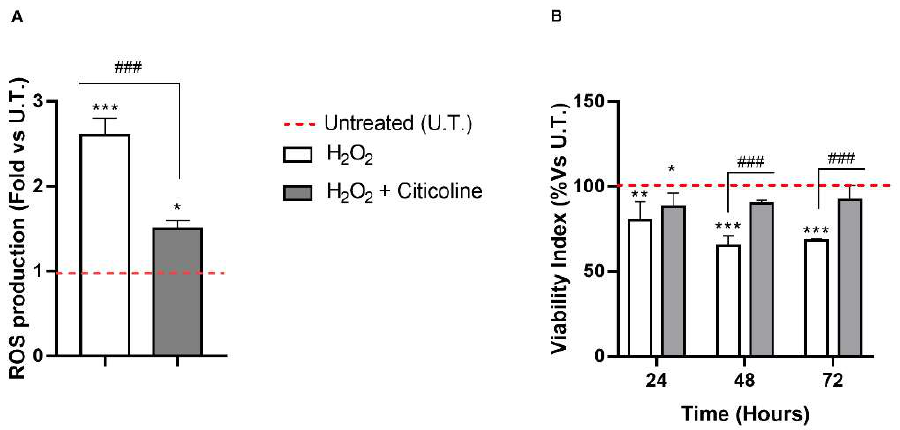
Figure 1. Citicoline counteracts H 2 O 2 -mediated cytotoxicity in HTMC. ( A ) DCF Assay was performed on untreated and treated HTMCs, and fluorescence was recorded at 2 h of experimental procedures. Data are expressed as a fold of ROS production and represent the mean ± SD of three independent experiments, each performed six times. ( B ) The Alamar blue assay was performed on the same sample after 24, 48 and 72 h of daily treatments. Data are expressed as a % of viability and represent the mean ± SD of three independent experiments. *** p < 0.001, ** p < 0.01, * p < 0.05 vs. untreated (UT) HTMCs; ### p < 0.001 vs. treated HTMCs (two-way ANOVA followed by Bonferroni post-test).